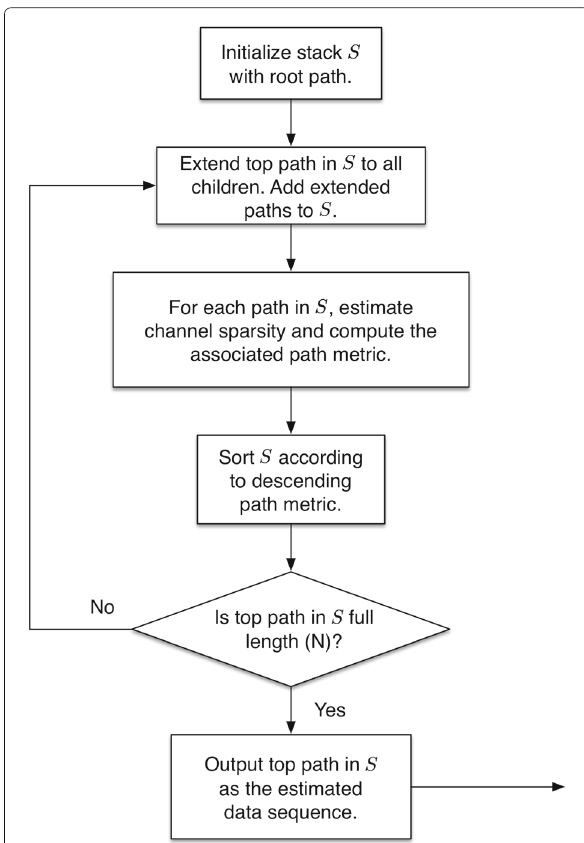
Fig. 2 A flow chart representation of the MA-SA